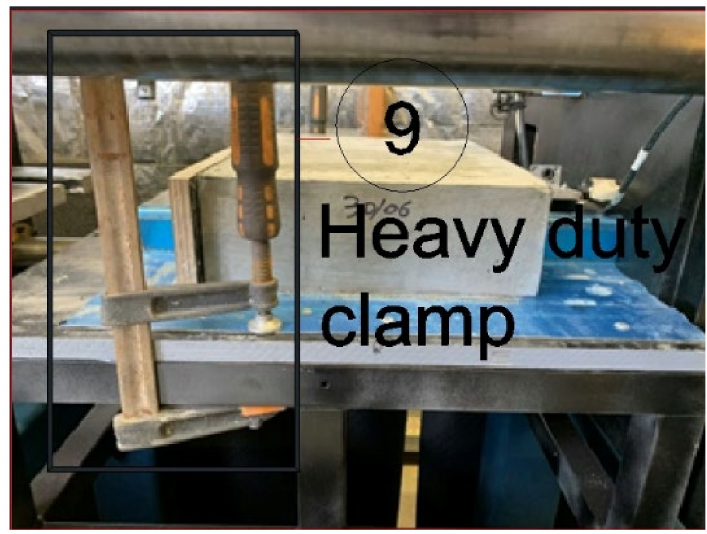
Figure 13. Heavy duty